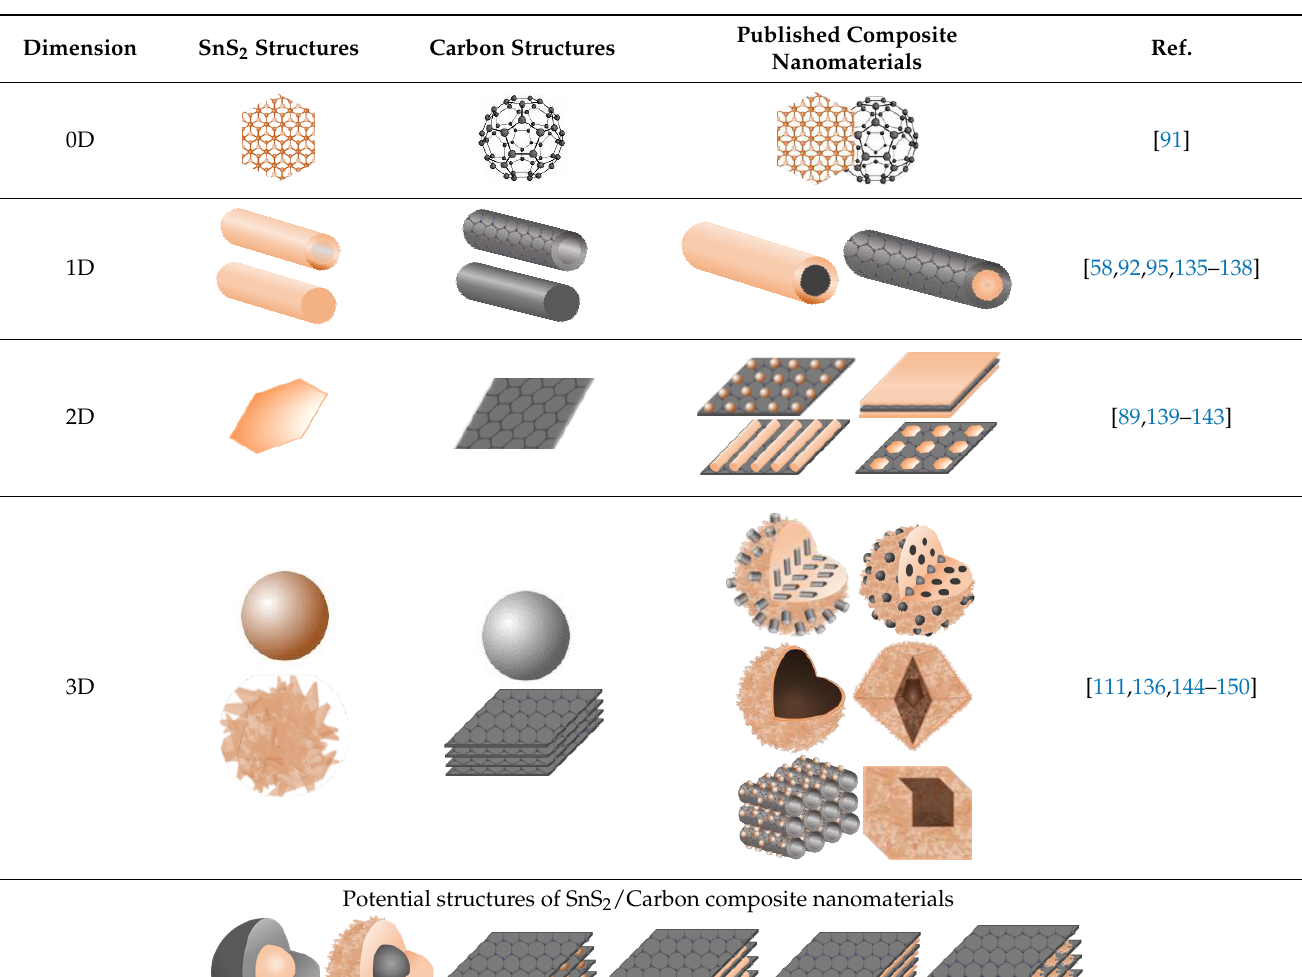
Table 2. Schematic comparison of different hybrid nanostructures of SnS 2 /Carbon composite nano- materials.